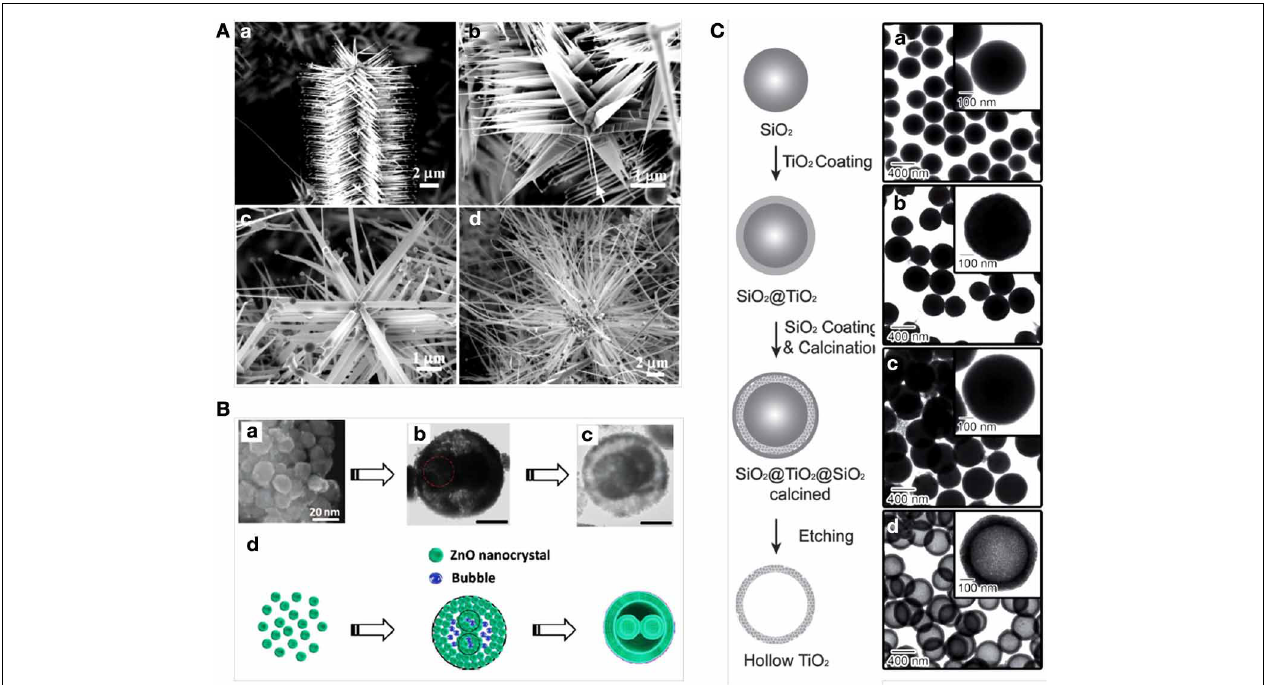
FIGURE 1 | (A) ZnO nanopropeller synthesized by vapor deposition; (B) Ostwald ripening utilized to prepare ZnO hollow spheres with double-yolk egg architectures; (C) Silica sphere templated synthesis for mesoporous anatase TiO 2 hollow structure. [Reprinted with